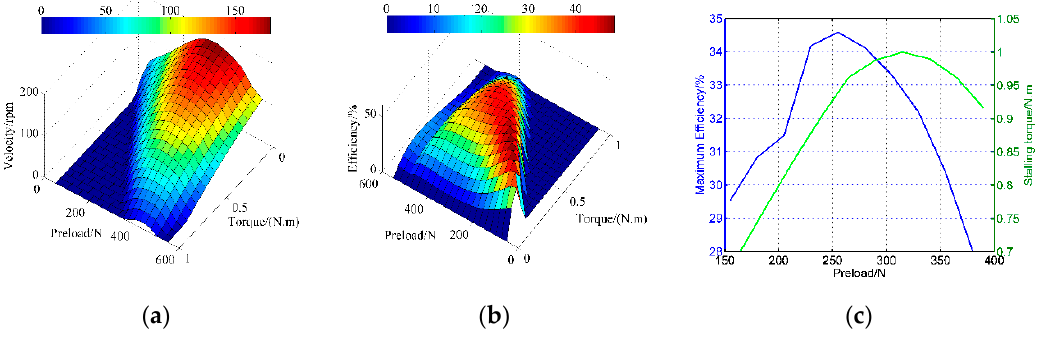
Figure 8. Simulation results of mechanical characteristics for different cases of pre-stressing forces: ( a ) revolving speed versus torque; ( b ) efficiency versus torque; ( c ) the calculated maximum efficiency and stalling torque.